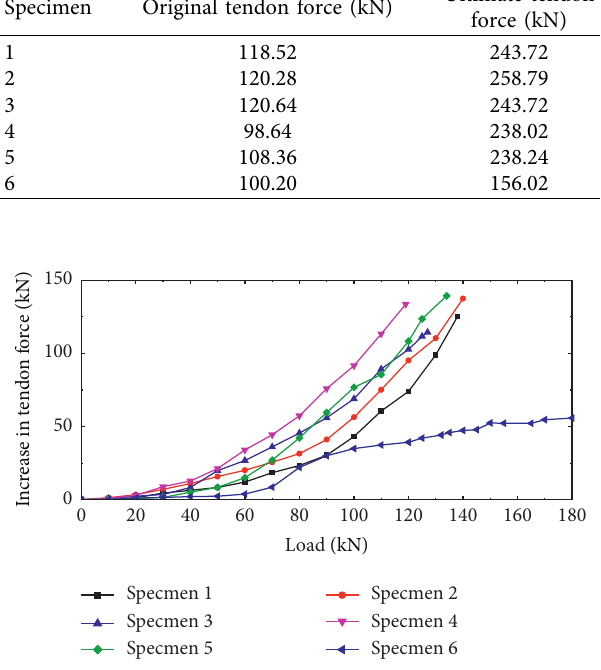
Figure 6: Increase in tendon forces during loading.